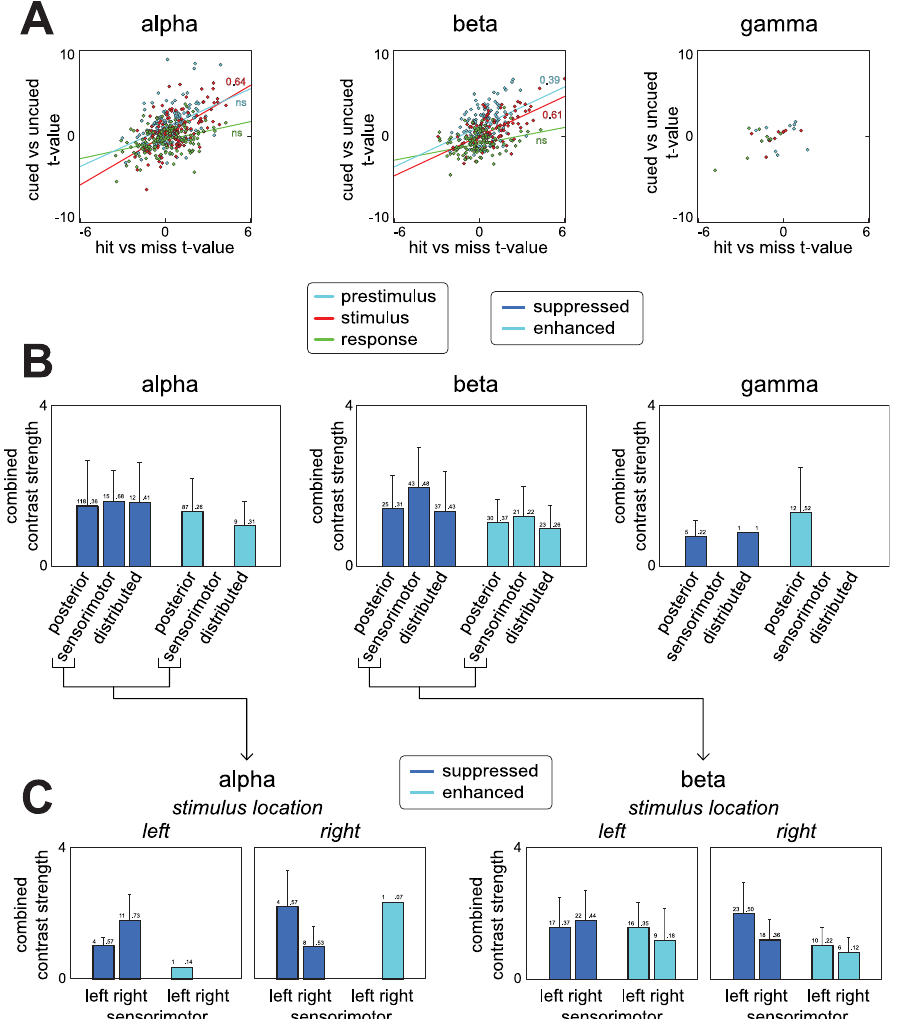
Fig 8. Task modulation of neuronal activity revealed by the trial profiles of all 783 components. We show average source activity contrasted as a function of attention, and subject ’ s performance on the task, for all 783 components. A , attention and performance contrasts expressed by t-values as a function of the three task periods. Lines are obtained via least squares fitting. Activity modulations of alpha and beta components during stimulus processing were positively related: components that were less active on attended trials (cued) were often also less active on trials where the stimulus was detected (hit), and vice versa. Pearson ’ s correlations were 0.64 (p < 5 * 10^ -6 ) and 0.61 (p < 5 * 10^ -4 ) for alpha and beta resp. Beta component activity during stimulus preparation showed a similar relation with a Pearson correlation of 0.39 (p < 0.005). Correlations for gamma components were not computed due to the low number of components. These analyses revealed that there are sources whose activity is ‘ suppressed ’ (both less active on cued and hit trials) and ‘ enhanced ’ (both more active on cued and hit trials). B , combined strength of both contrasts as a function of three spatial categories. Bars indicate SD. The spatial categories describe posterior, sensorimotor ( ‘ left/right sensorimotor ’ ), and distributed components. On the top of each bar, we show the number of suppressed/enhanced components present within each category, as well as the proportion w.r.t. the total number of components within each category. C , same as in B, but split up for left and right sensorimotor cortex and for trials in which the stimulus arrived on the left thumb or the right thumb. B and C show that there were sources whose alpha rhythms were suppressed in both task relevant regions (sensorimotor) and task irrelevant regions (posterior and others), and that there were sources whose beta rhythms were suppressed and enhanced in both task relevant regions (sensorimotor) and task irrelevant regions (posterior and others). This suggests a complex situation where sources that are located close to each other can be both beneficial and detrimental to the